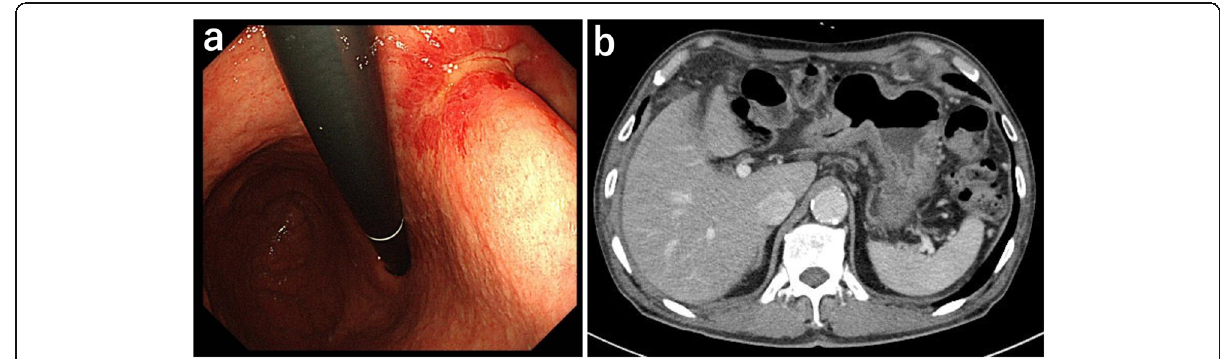
Fig. 3 Imaging after combined therapy. a Gastroscopy showed only a small ulcer in the area of the original tumor. b Computed tomography scan showed reduced thickening of the gastric wall and marked shrinkage of regional lymph